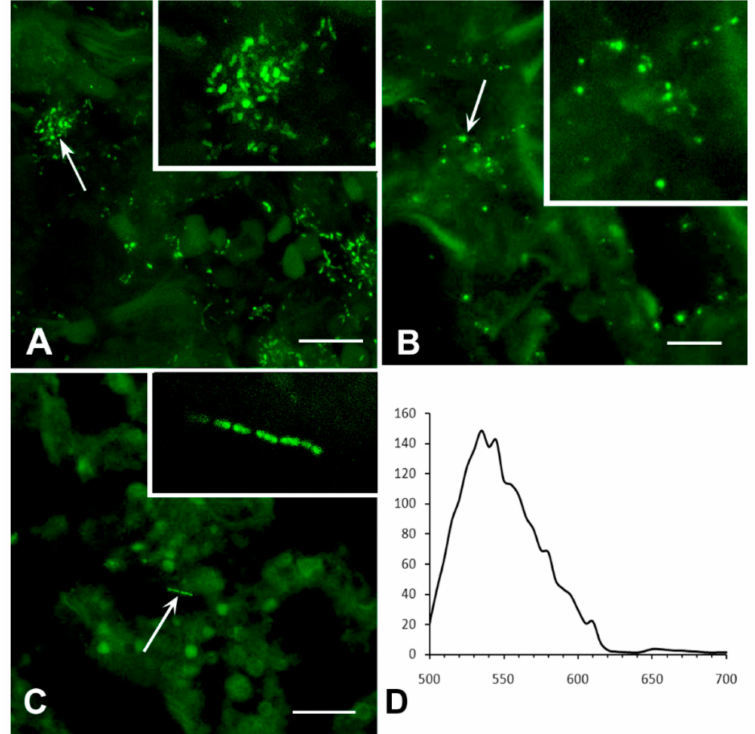
Figure 4. Immunolabelling of M. tuberculosis in lung tissue; the perifocal region of TB inflammation. M. tuberculosis are presented as large ( A ) or small aggregations ( B ), and solitary chain-like colonies ( C ) Insets: High magnification of the structures indicated by arrows. Scale bars = 10 µ m. ( D ) The emission spectrum of the chain-like colony, shown in ( C ), corresponds to the spectrum of the fluorescent marker Alexa-488. The abscissa shows emission wavelength (nm); the ordinate shows relative